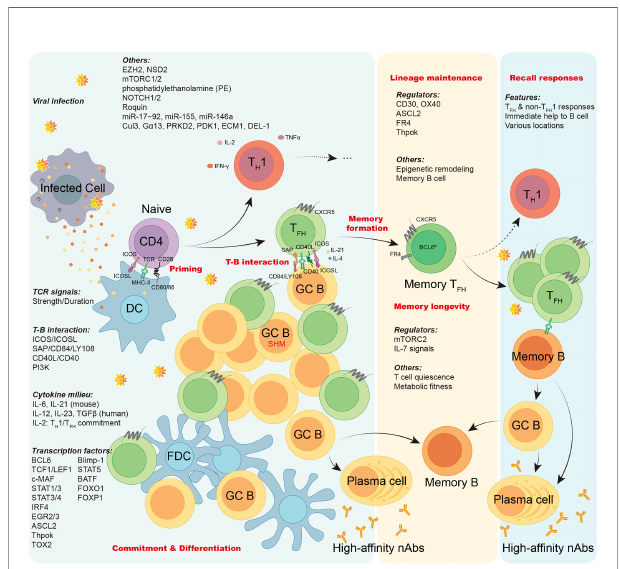
FIGURE 2 | The generation, maintenance, and functions of virus-speci fi c TFH cells. In viral infection, antigen presenting cells like dendritic cells (DCs) conduct antigen uptake, processing, and presentation to prime naïve virus- speci fi c CD4 + T cells, inducing T cell activation. Upon activation, virus-speci fi c CD4 + T cells are mainly committed into either T H 1 cells or T FH cells. The lineage commitment and differentiation of T H 1/T FH cell are orchestrated under the regulation of TCR signals, T-B interaction, cytokine milieu, transcription factors, and other factors as illustrated. Virus-speci fi c effector T FH cells work on initiating GC responses, facilitating the cognate B cell maturation, promoting generation of long-lived memory B cells and high-af fi nity neutralizing antibodies. Memory virus-speci fi c T FH cells are developed and sustained after viral clearance under the regulation of a variety of regulators, epigenetic remodeling, and cognate memory B cells. The longevity of memory T FH cells are guaranteed by T cell quiescence and viability conferred by mTORC2 signaling. Upon re- challenge of encountered viruses, memory virus-speci fi c T FH cells provide immediate help to cognate memory B cells, promoting robust cellular and humoral recall